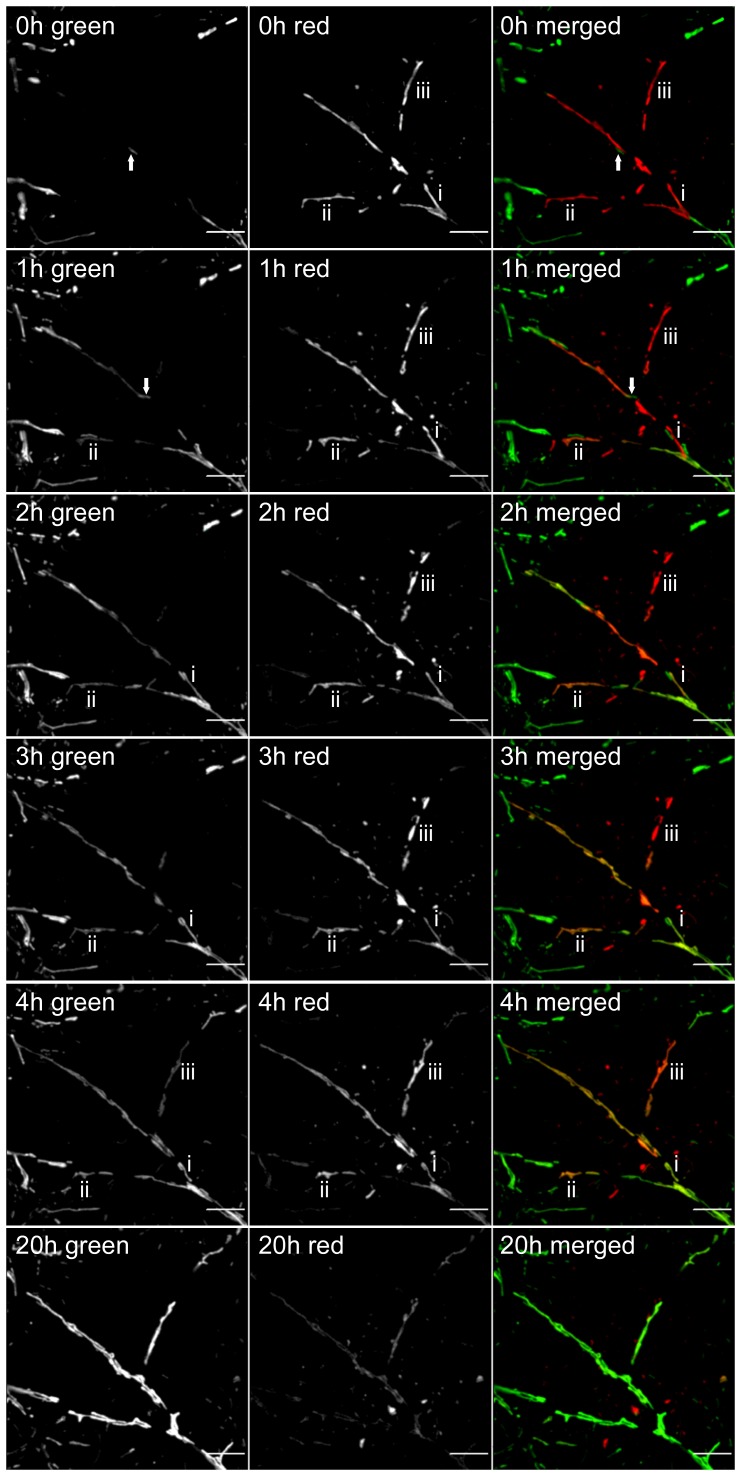
Time course of the fusion of individual mitochondria.A living neurite (28 div) with mitochondria containing photoconverted mitoKaede was imaged over several hours. The appearance of green fluorescing mitoKaede within individual red fluorescing mitochondria (labeled i- iii) during 4 hours of observation is seen. The arrow indicates the location of a mitochondrion that had entered the field of view before the first image was taken. By 20 hours, the red fluorescent protein was distributed throughout the mitochondria under observation. Scale bars correspond to 5 microns.